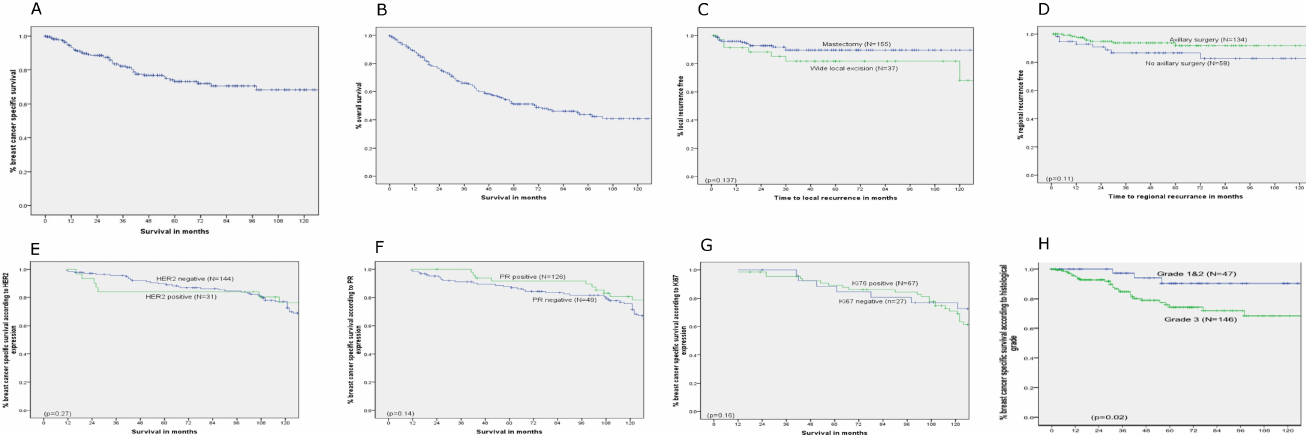
Fig 1. Kaplan-Meier plots of time-dependant outcome variables in older women with ER-negative early operable primary breast cancer. (A) Breast cancer specific survival of Oestrogen receptor negativeearly operableprimary breast cancer in older women. (B) Overall survival of Oestrogen receptornegative early operableprimary breast cancer in older women. (C) Local recurrencefree survival of Oestrogen receptornegative early operable primary breast cancer in older women- Mastectomy versus wide local excision. (D) Regionalrecurrencefree survival of Oestrogen receptor negativeearly operableprimary breast cancer in older women- Axillary surgery versus no axillarysurgery. (E) Breast cancer specific survival of Oestrogen receptor negativeearly operableprimary breast cancer in older women- Progesterone Receptor(PR) positive versus negative. (F) Breast cancer specific survival of Oestrogen receptor negativeearly operableprimary breast cancer in older women- Human Epidermal Growth Factor Receptor–2 (HER2) positive versus negative.(G) Breast cancer specific survival of Oestrogen receptor negativeearly operableprimary breast cancer in older women- Ki67 positive versus negative.(H) Breast cancer specific survival of Oestrogen receptor negativeearly operableprimary breast cancer in older women- Low (ie 1–2) Grade versus high (ie 3) Grade.